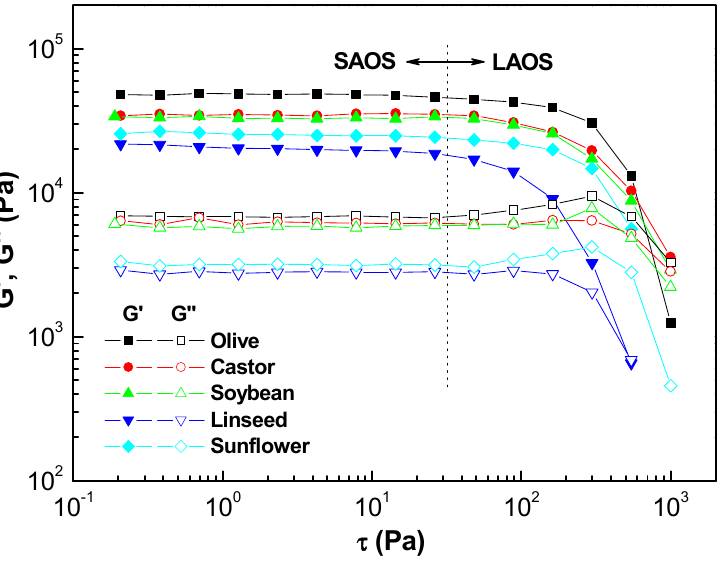
Figure 1. Oscillatory shear stress sweeps for oleogels formulated with different vegetable oils. Table 1. Rheological parameters for oleogels studied.